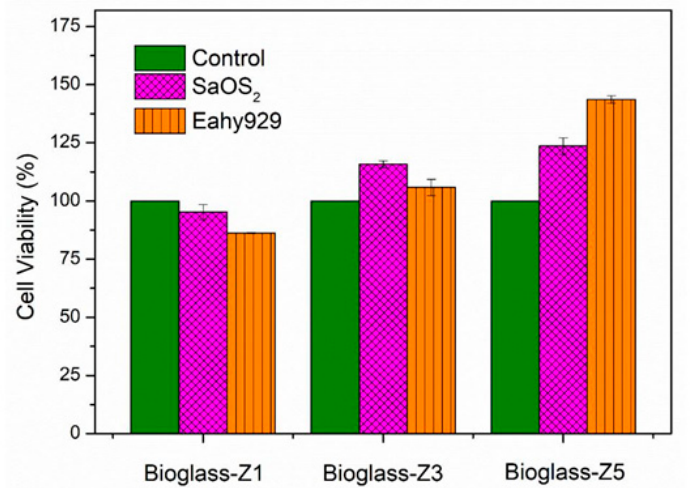
Figure 7. Cell viabilities on bioactive glasses 70SiO 2 –(30-x)CaO–xZnO (mol.%, x = 1, 3, 5) for 24